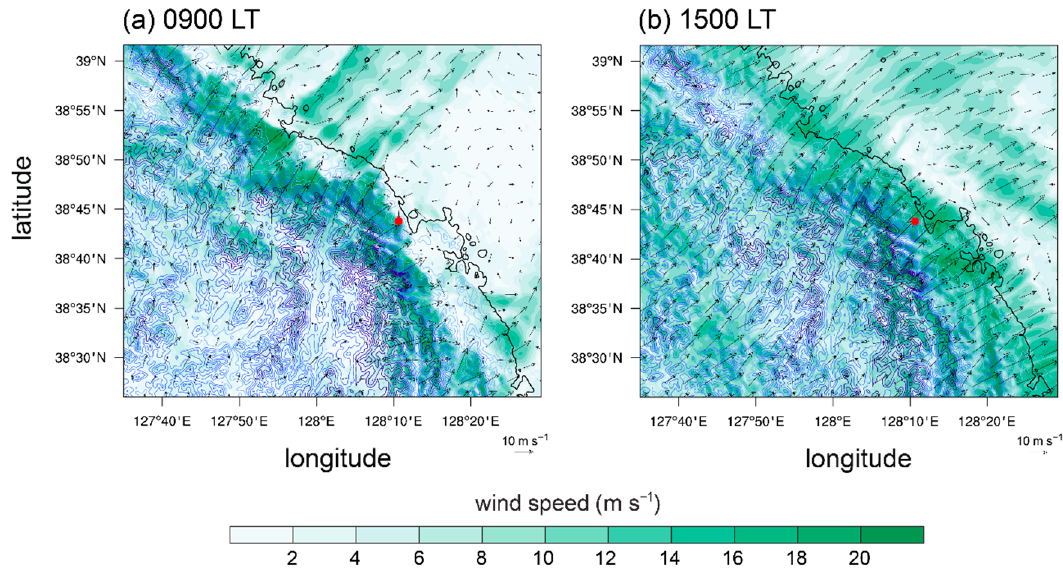
Figure 8. Simulated 10-m wind speed and the wind vector fields in A1 at ( a ) 0900 LT and ( b ) 1500 LT. The terrain height (blue lines) is contoured up to 1500 m in intervals of 100 m. The red circle indicates the location of Jangjeon station.